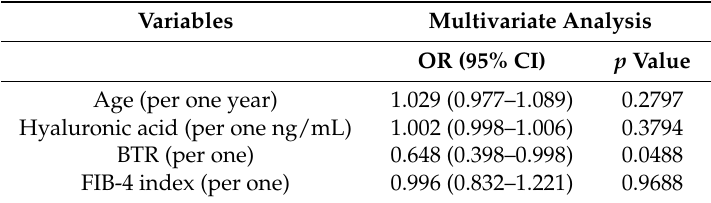
Table 3. Multivariate analysis of factors contributing to the increased